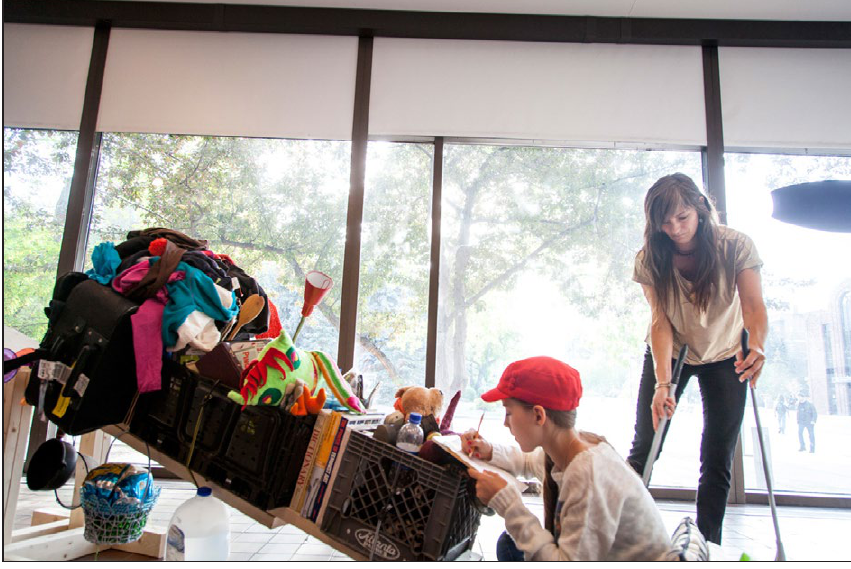
Figure 3: Courtney Kessel. In Balance With . . . 2011 ongoing. Photo courtesy of Michael